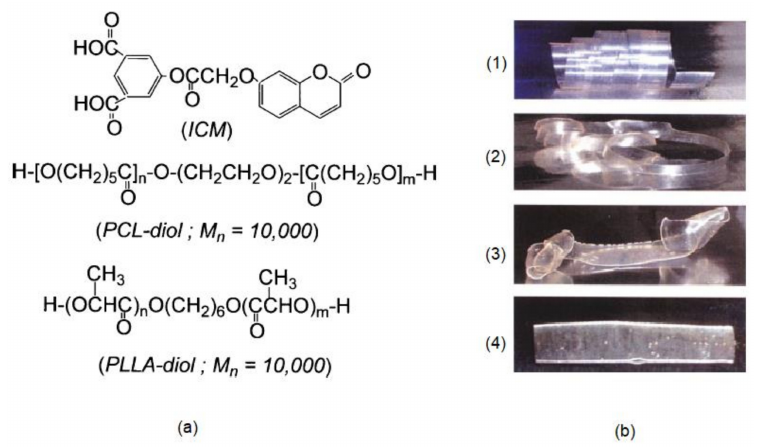
Figure 36. ( a ) Chemical structures of used compounds. ( b ) The image of shape-memory effect of photocross-linked 7-(3,5-dicarboxyphenyl) carbonylmethoxycoumarin (ICM)/polycaprolactone (PCL)-10,000 for transition from temporary (1) to permanent shape (4) at 60 ◦ C. Adapted from [199], with permission from John Wiley and Sons.